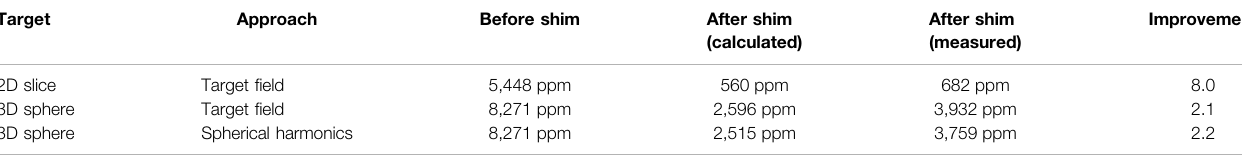
TABLE 1 | Summary of 2D and 3D shimming results using the target fi eld or spherical harmonics approach and the genetic algorithm.